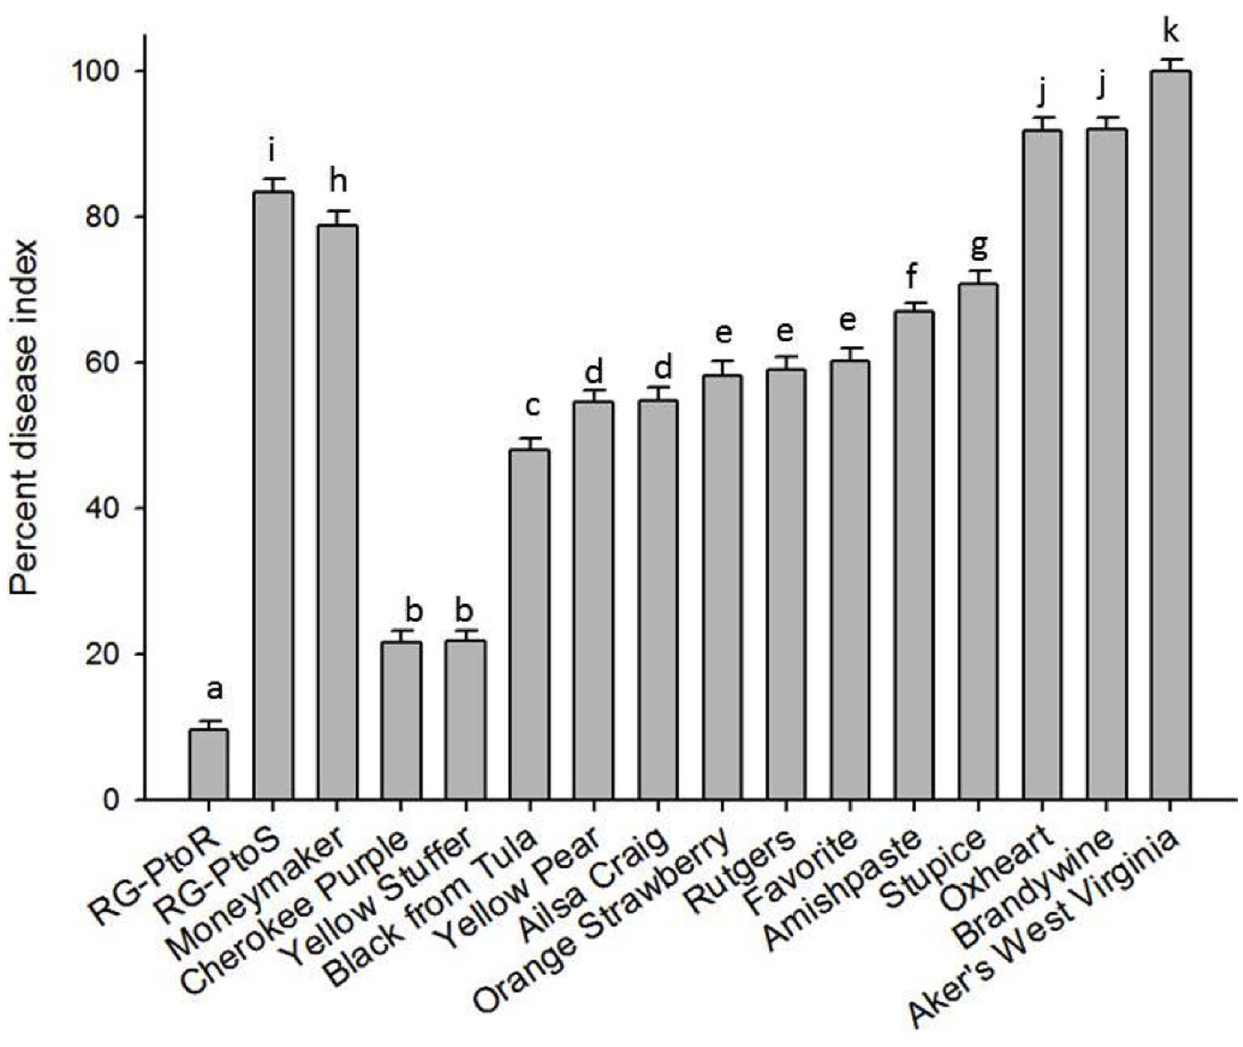
Figure 2. Response of heirloom tomatoes to NC-C3 in the field. Disease severity of heirloom tomatoes inoculated with race 0 Pst isolate NC- C3 under field conditions (summer 2012). RG-PtoR has the Pto gene and was included as a resistant control. RG-PtoS and Moneymaker lack Pto and were included as susceptible controls. Inoculated plants were scored at 7 dpi using a 0–5 scale as described in Materials and Methods. Mean percent disease index (PDI; see Methods) was calculated from the disease scores of each genotype by totaling the score of 18 plants (three replicates each of 6 plants per line) and expressing the value as a percentage (%). Means marked with the same letter are not statistically different at a 5% probability level based on least significant difference